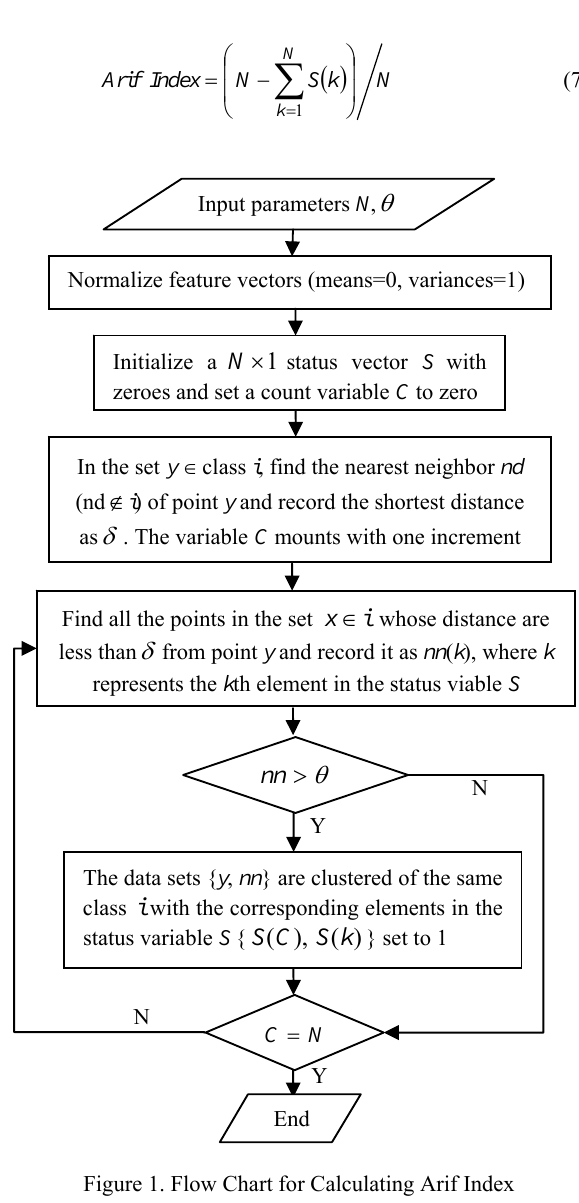
Figure 1. Flow Chart for Calculating Arif